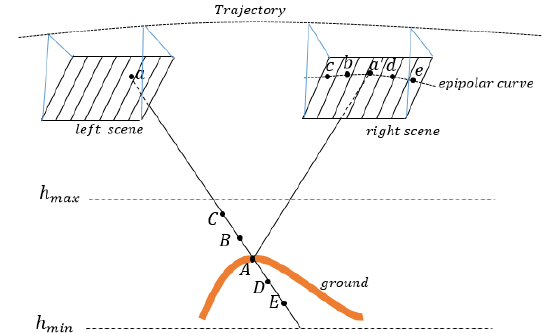
Figure 1. Epipolar geometry in linear array